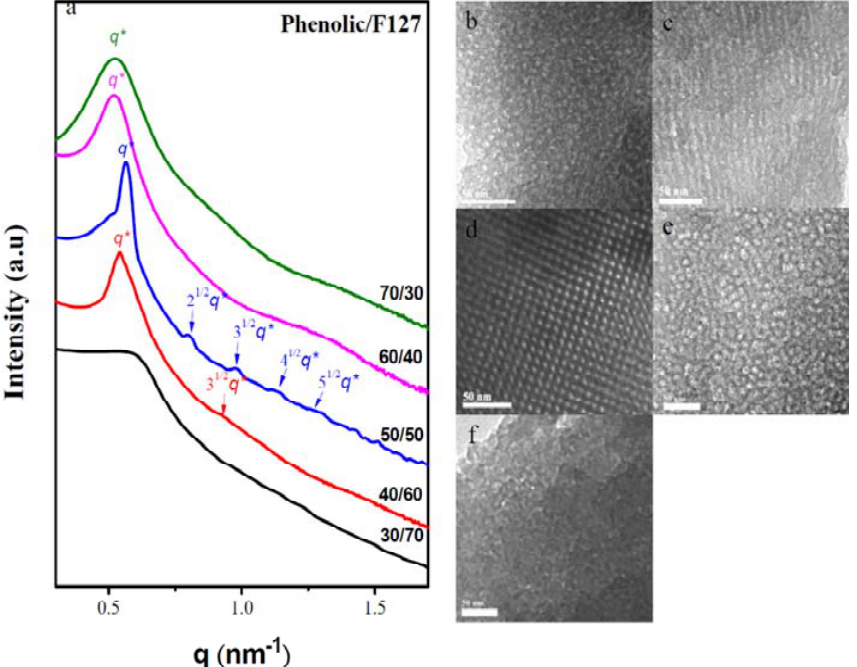
Figure 6. ( a ) Small-angle X-ray scattering (SAXS) patterns and ( b – f ) transmission electron microscopy images of mesoporous phenolic templated by F127 at